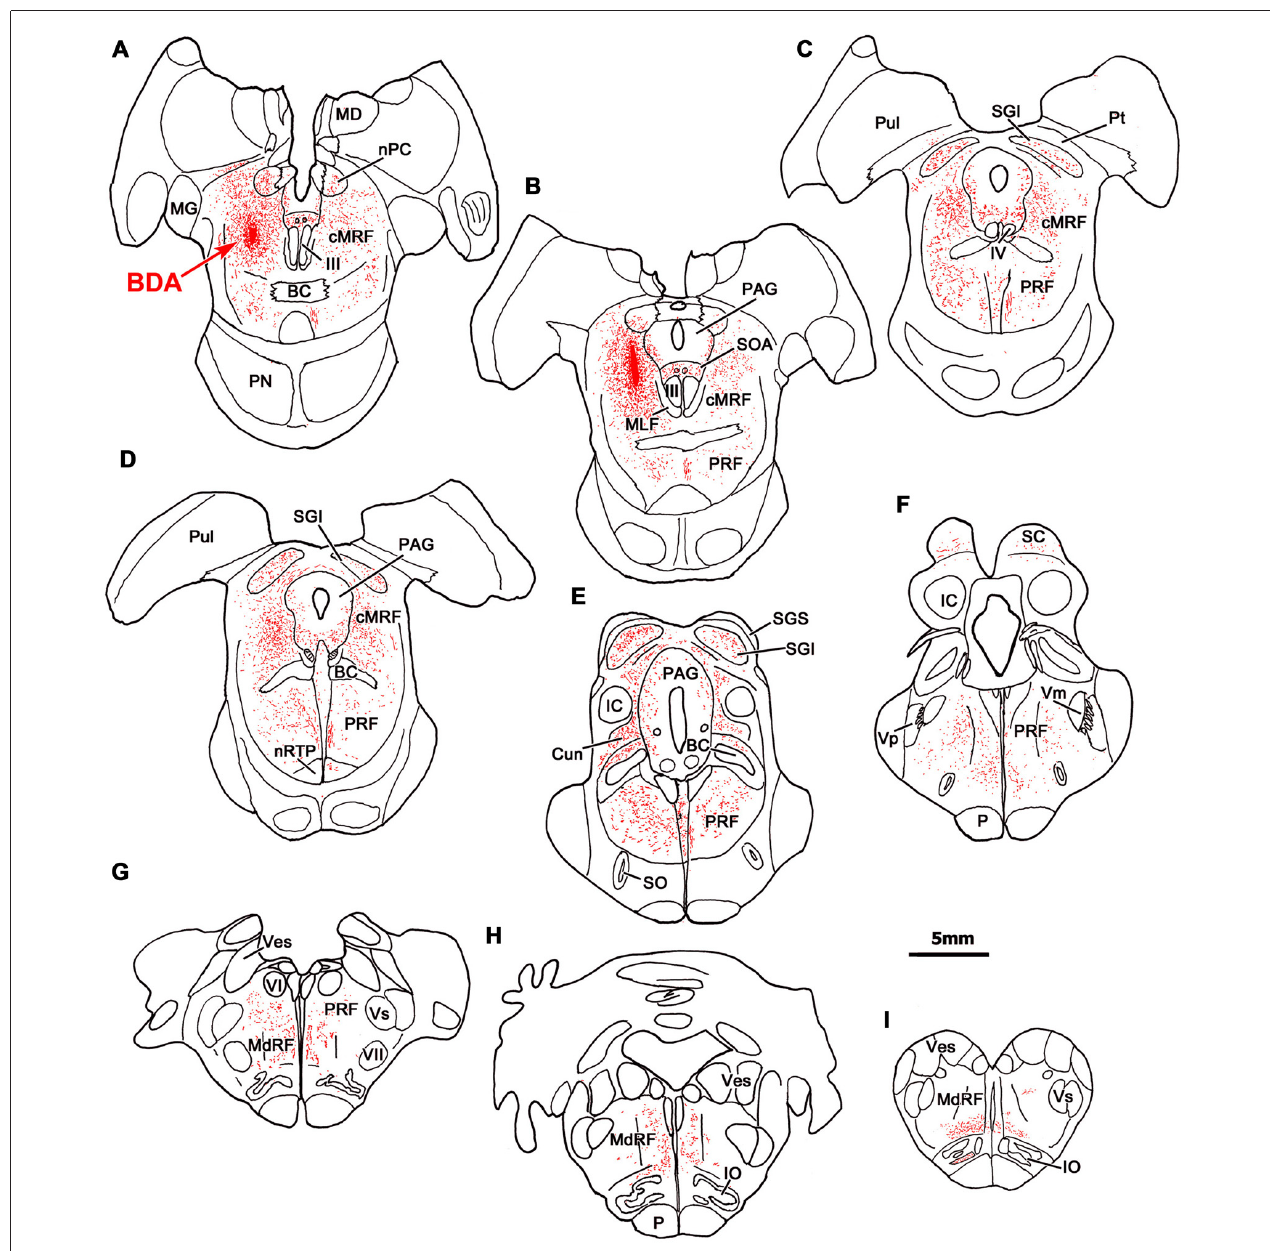
FIGURE 1 | Distribution of central mesencephalic reticular formation (cMRF) terminals labeled by biotinylated dextran amine (BDA). The distribution of labeled terminals (stipple) and axons (lines) observed following a BDA injection into the cMRF (A,B) is charted on a rostral to caudal series of sections through the midbrain (A–F) , pons (A–G) and medulla (G–I)